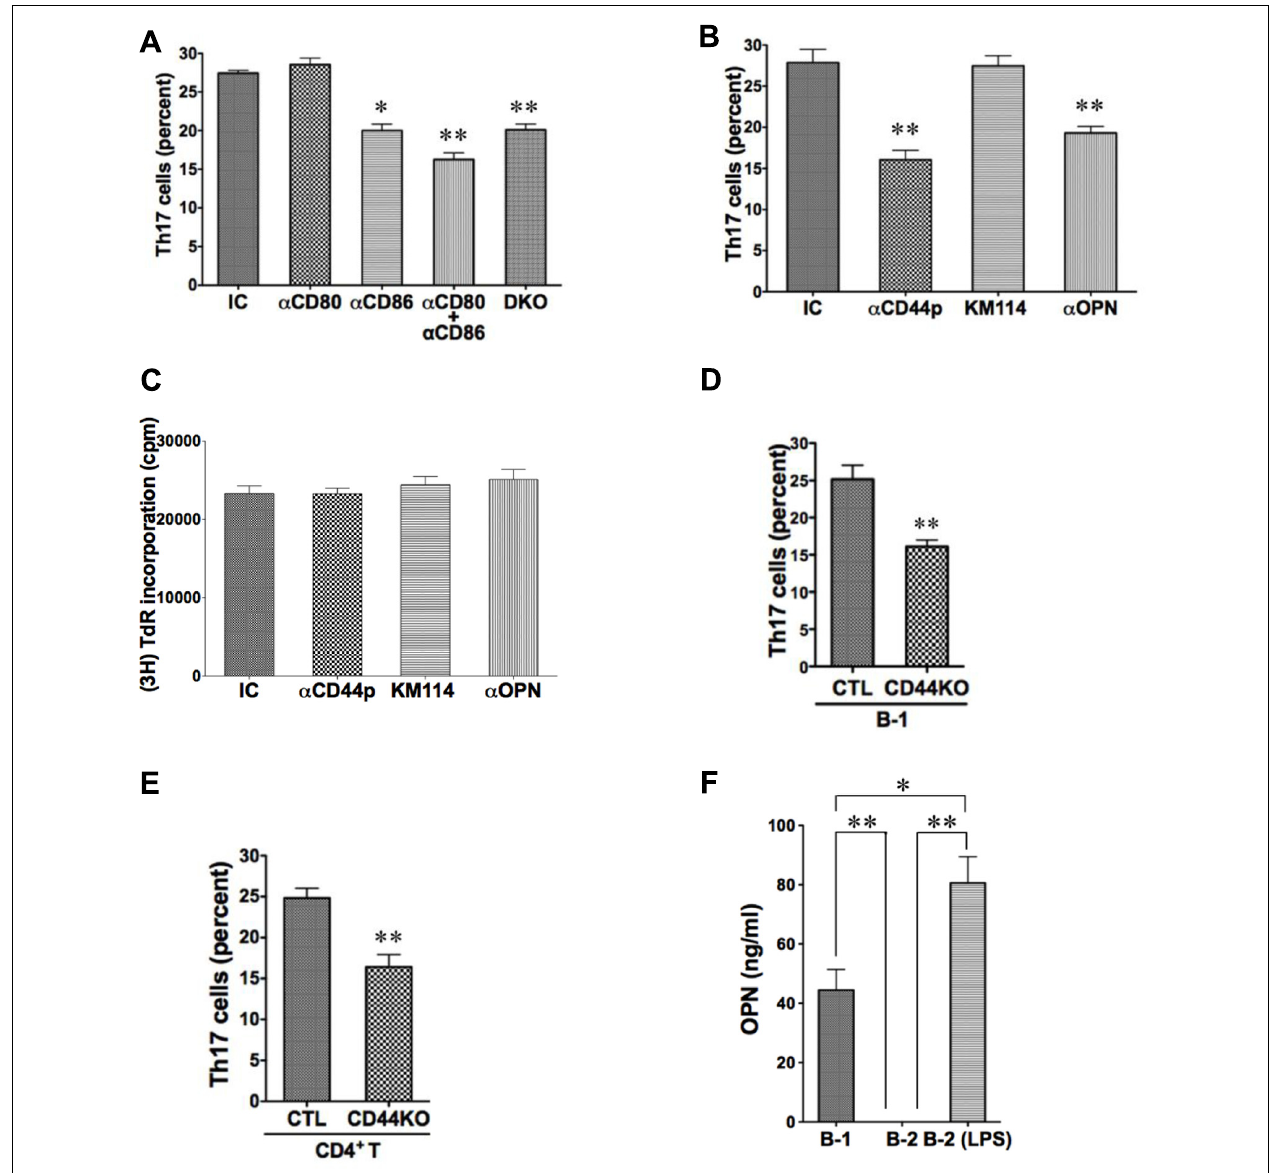
FIGURE 2 | CD44 and CD86 contribute to B-1 cell-inducedTh17 cell differentiation. (A) Sort-purified C57BL/6 peritoneal B-1 cells were co-cultured at a 1:2 ratio with magnetic bead selected CD4 + T cells from BALB/c mice in the presence ofTh17 polarizing conditions with or without neutralizing antibodies directed against CD80 ( α CD80) or CD86 ( α CD86) or both, or with isotype control antibody (IC), as indicated. Sort-purified peritoneal B-1 cells from CD80/CD86 double knock-out mice on the C57BL/6 background (DKO) were co-cultured at a 1:2 ratio with magnetic bead selected CD4 + T cells from BALB/c mice. After 5 days expression of intracellular IL-17 was assessed by flow cytometry. Mean values are shown along with lines indicating SEMs ( n = 3). (B) Sort-purified BALB/c B-1 cells were co-cultured at a 1:2 ratio with magnetic bead selected CD4 + T cells from C57BL/6 mice in the presence ofTh17 polarizing conditions with either isotype control antibody (IC), polyclonal anti-CD44 antibody ( α CD44p), KM114 monoclonal anti-CD44 antibody (KM114), or anti-OPN antibody ( α OPN), each at 10 μ g/mL. After 5 days expression of intracellular IL-17 was assessed by flow cytometry. Mean values are shown along with lines indicating SEMs ( n = 3). (C) Comparable cultures as described in B were harvested at 3 days